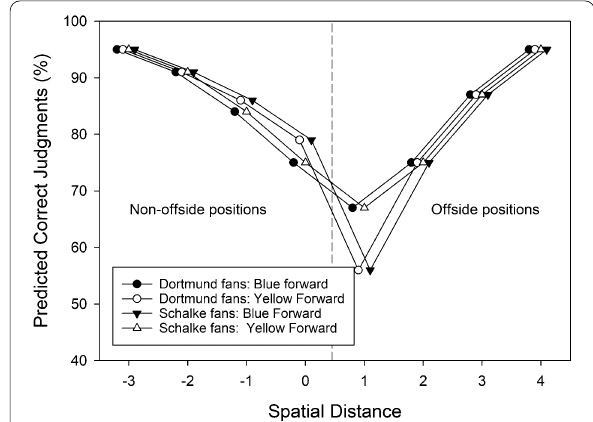
Fig. 2 Predicted effects of observers’ team preferences (Dortmund vs. Schalke) on offside judgments for blue or yellow forwards. Note that spatial distances from 3 to 0 refer to non-offside positions, − whereas the spatial distances from 1 to 4 refer to offside